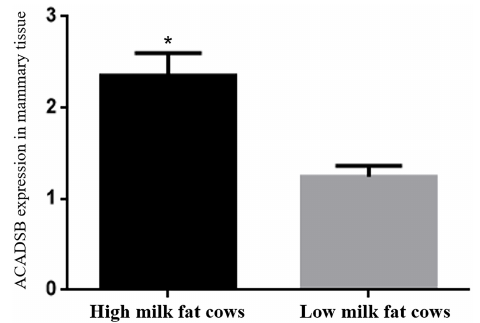
Figure 1. The ACADSB gene expression levels in mammary tissue of high milk fat and low milk fat